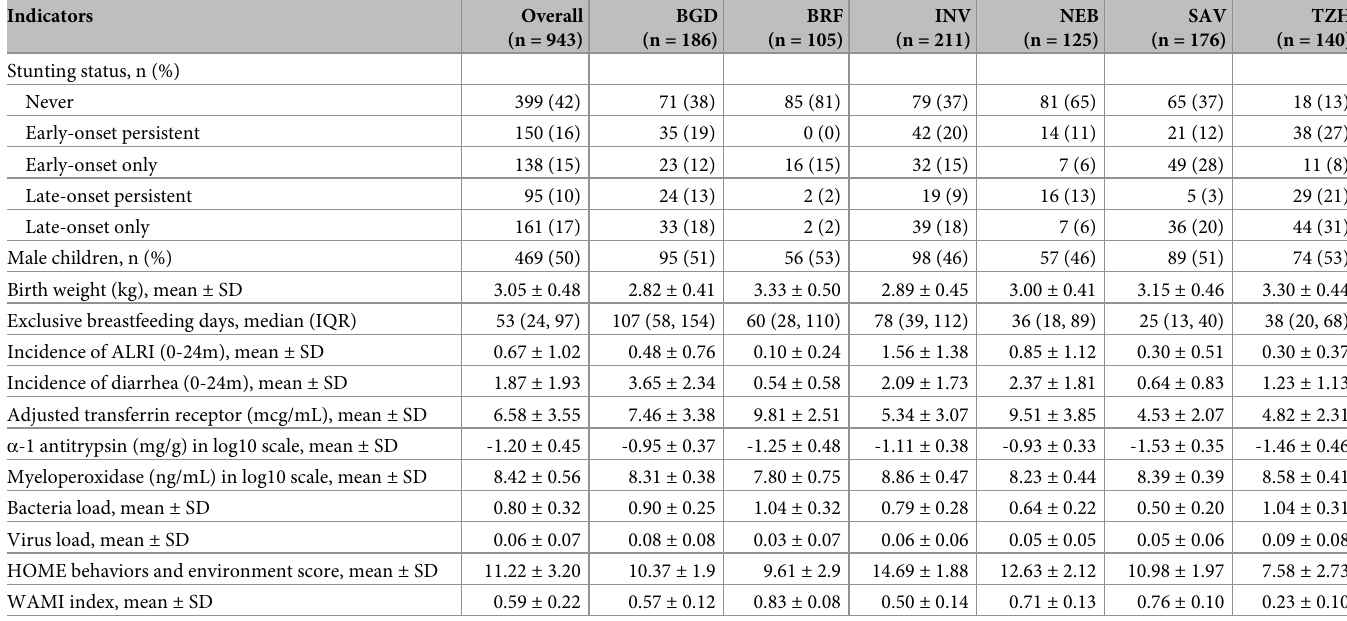
Table 1. Characteristics of the study